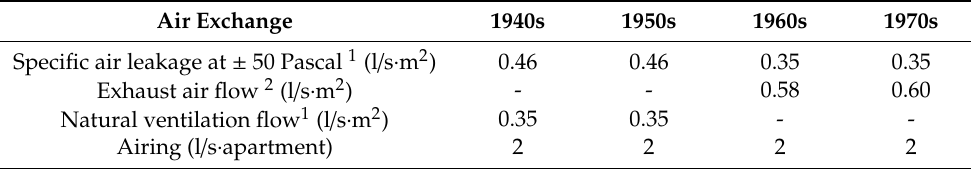
Table 6. Air tightness, ventilation flows, and airing of the studied